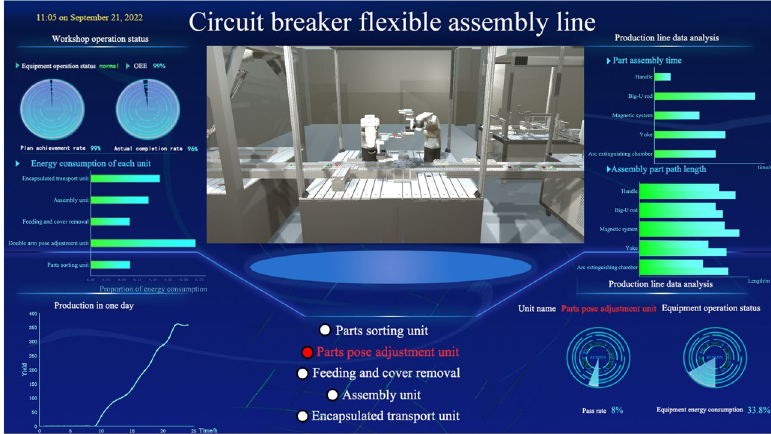
Figure 27. DT system unit interface of multi-robot cooperative CBFMS.